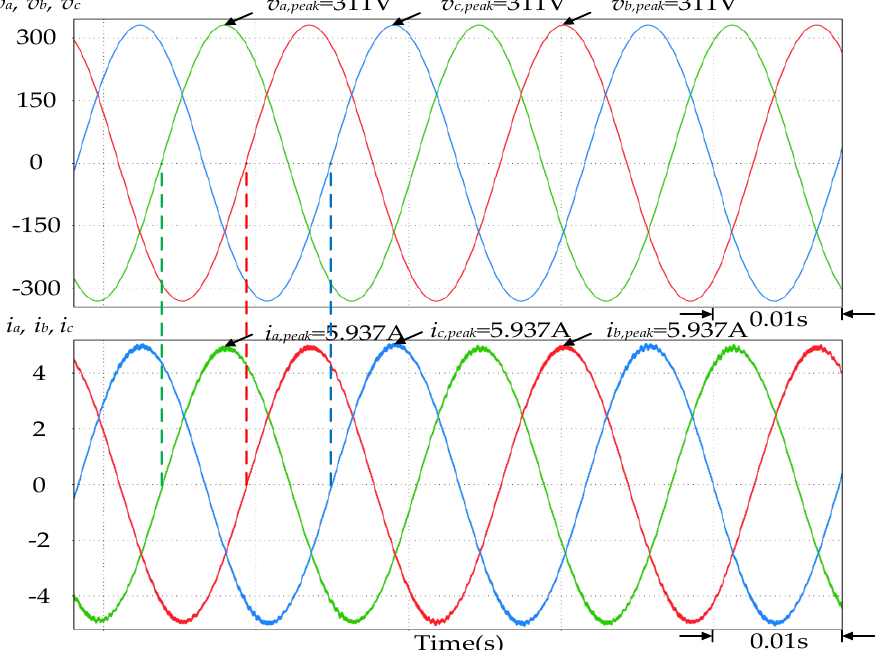
Figure 12. The three-phase output voltage and current waveforms of the smart inverter when the per-unit value of mains voltage equals 1p.u.